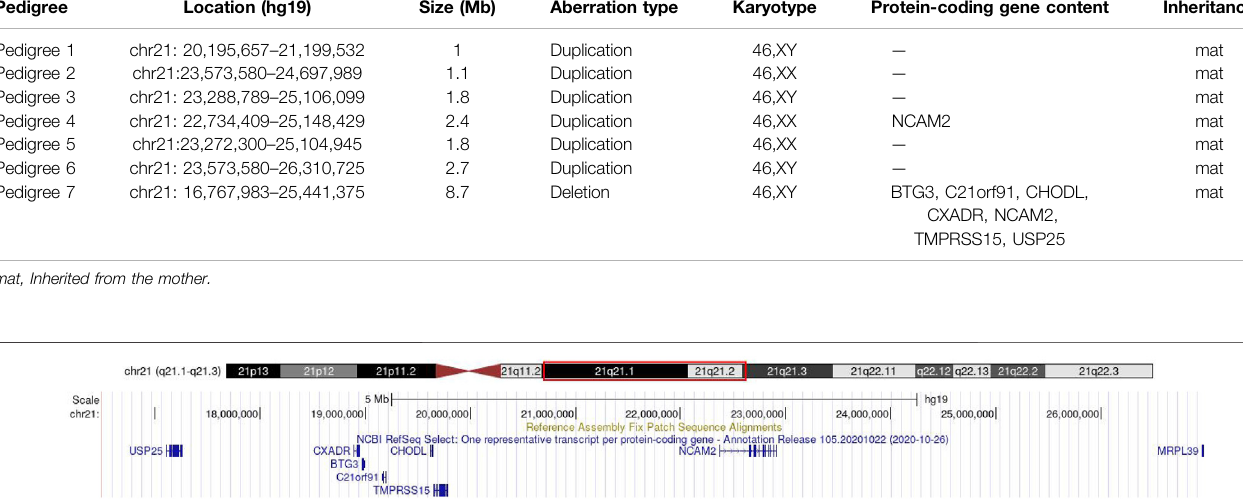
TABLE 1 | Chromosomal aberrations of the fetuses in seven pedigrees.